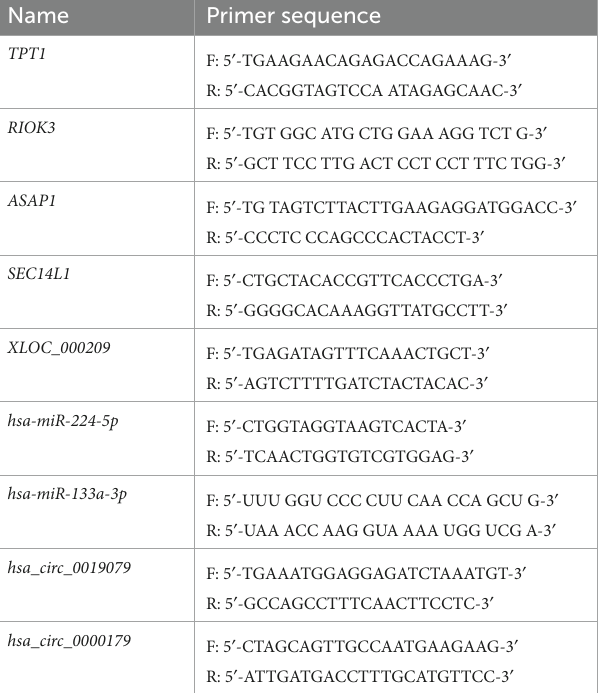
TABLE 3 Primers used for qRT-PCR analysis of DE mRNA and ncRNAs